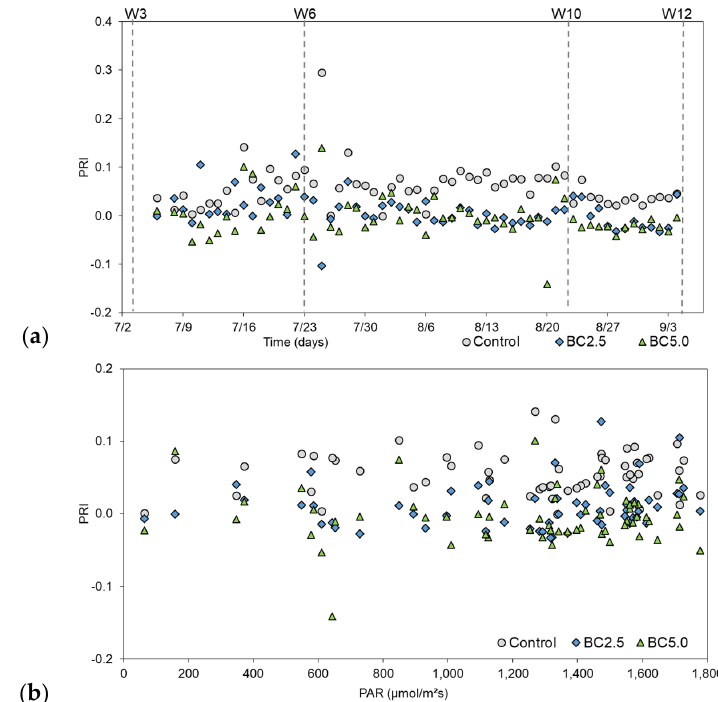
Figure 6. ( a ) Average midday photochemical reflectance index (PRI) values for the pepper plants and ( b ) relationship between PRI and belowground photosynthetically active radiation (PAR) for the control, BC2.5, and BC5.0 treatments. W3, W6, W10, and W12 represents the time of weeks when destructive plant sampling occurred.